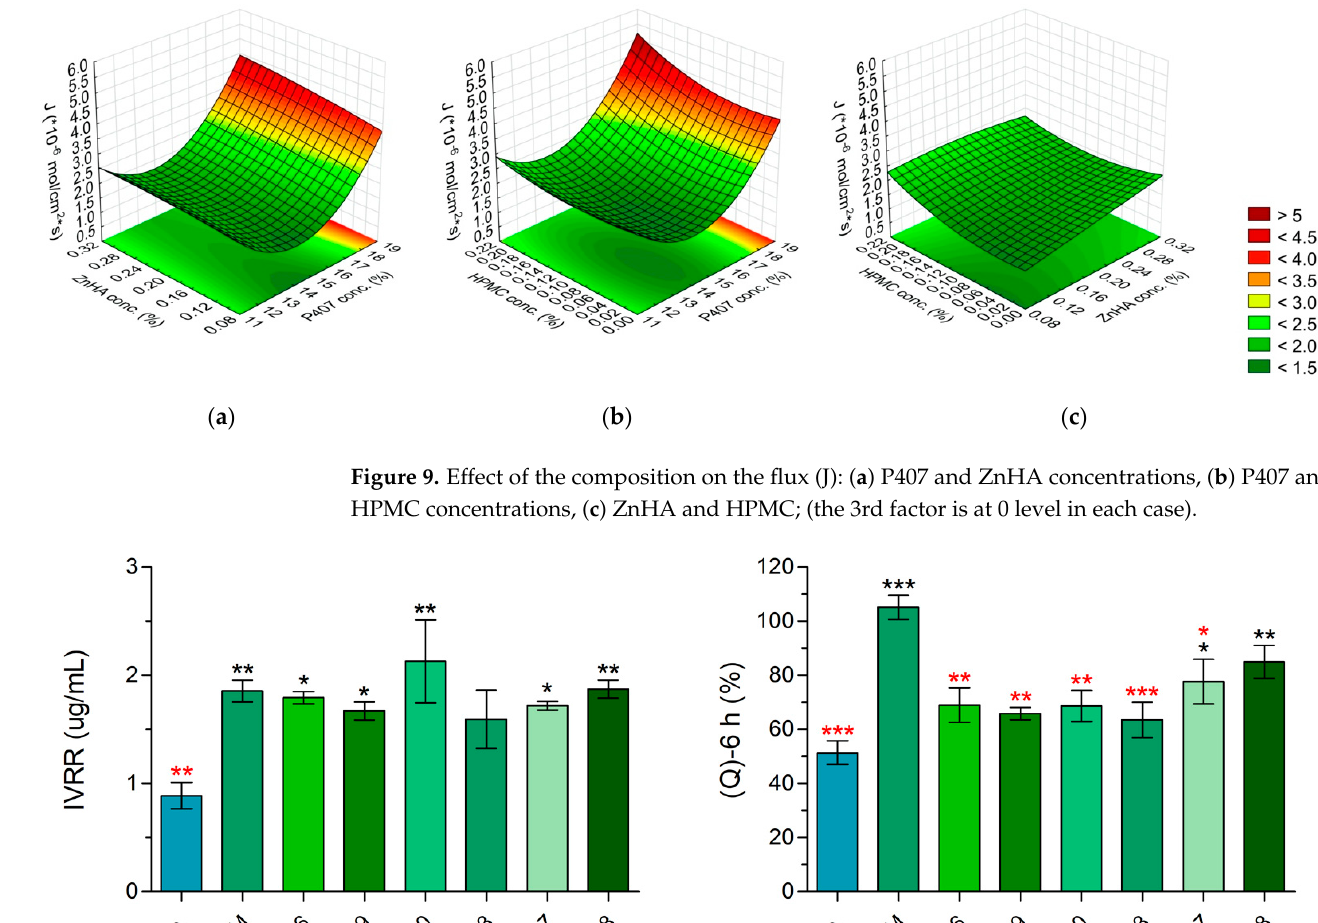
Figure 8. Effect of the composition on the permeability (Pe): ( a ) P407 and ZnHA concentrations, ( b ) P407 and HPMC concentrations, ( c ) ZnHA and HPMC; (the 3rd factor is at 0 level in each case).